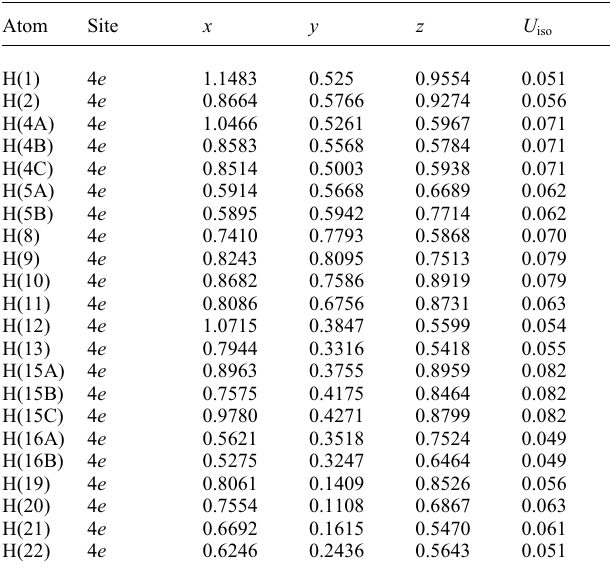
Table 2. Atomic coordinates and displacement parameters (in Å 2 )